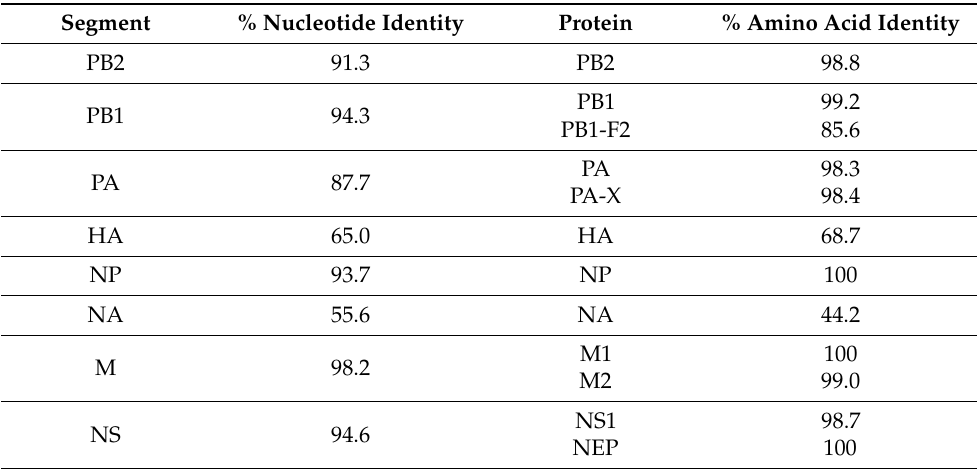
Table 2. Nucleotide and amino acid differences between A/wildbird/California/187718-36/2008 (H3N8) and A/mallard/Colorado/P66F1-5/2008 (H4N6) viruses.